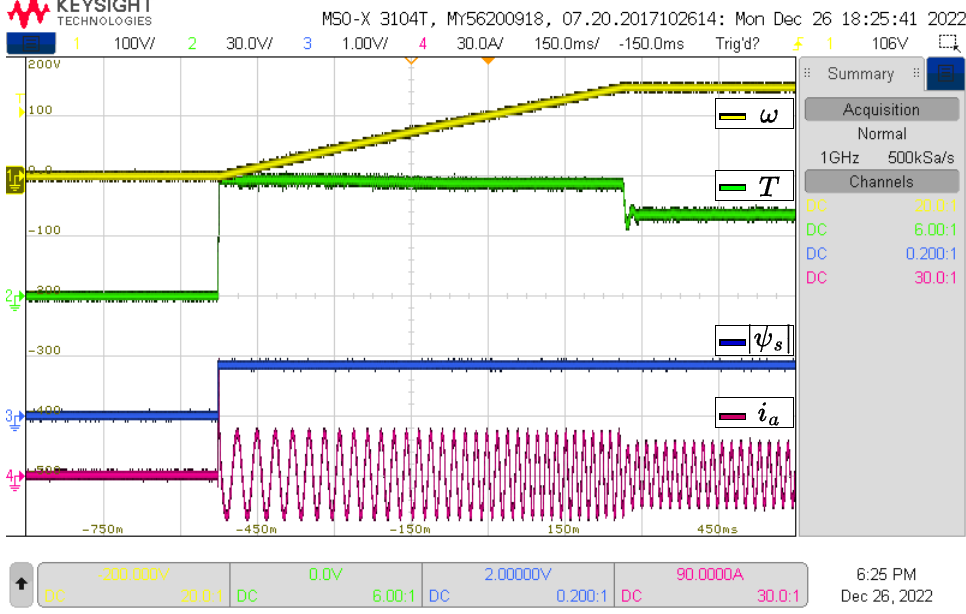
Figure 12. HIL Results for 3L-NPC with N = 4.